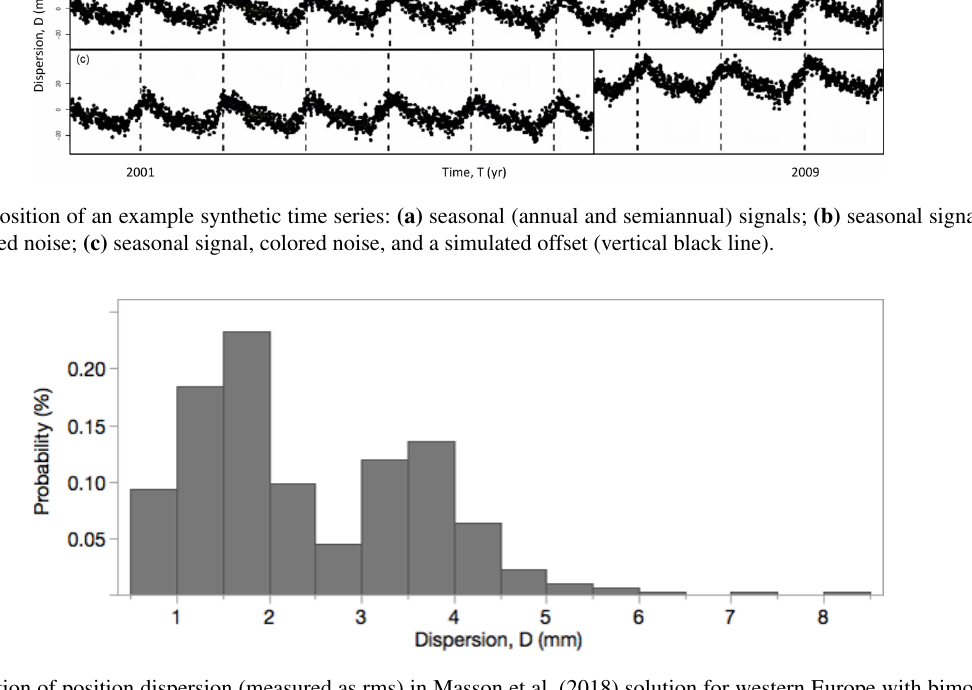
Figure 2. Distribution of position dispersion (measured as rms) in Masson et al. (2018) solution for western Europe with bimodal structure of the horizontal (0.7–3.2mm) and vertical (2.7–4.5mm)